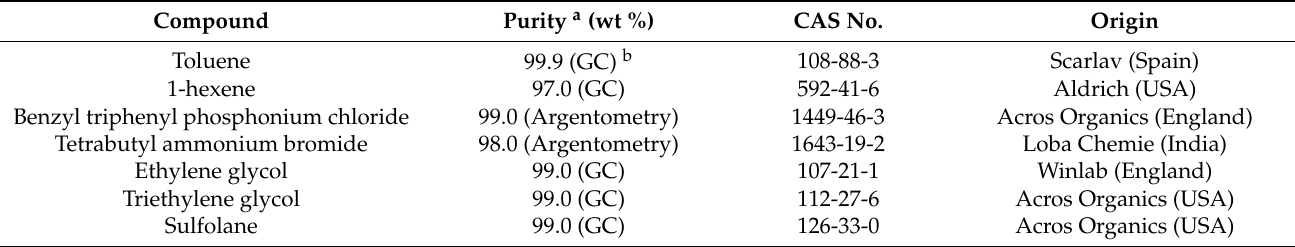
Table 3. Chemicals used in the experiment process.